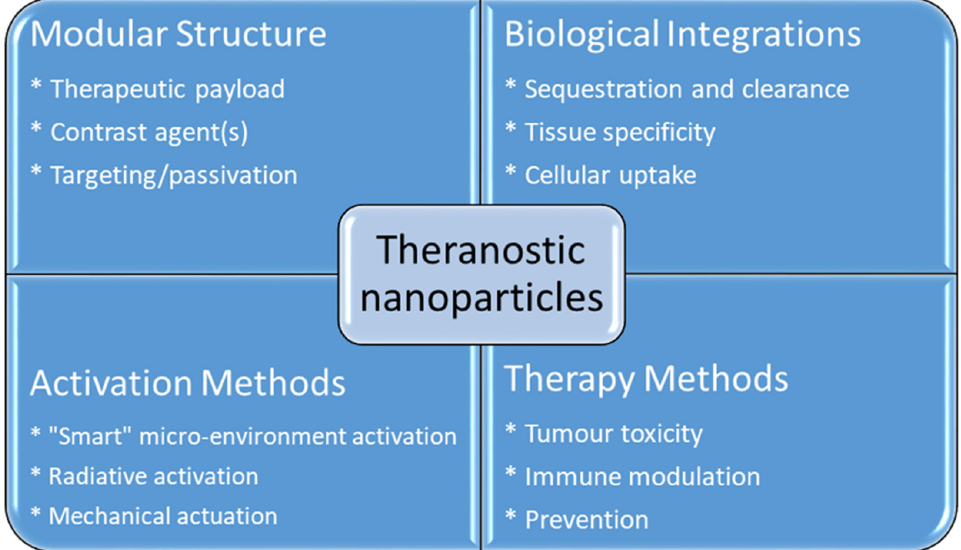
Figure 1. Advantages using nanoparticles in cancer theranostics.